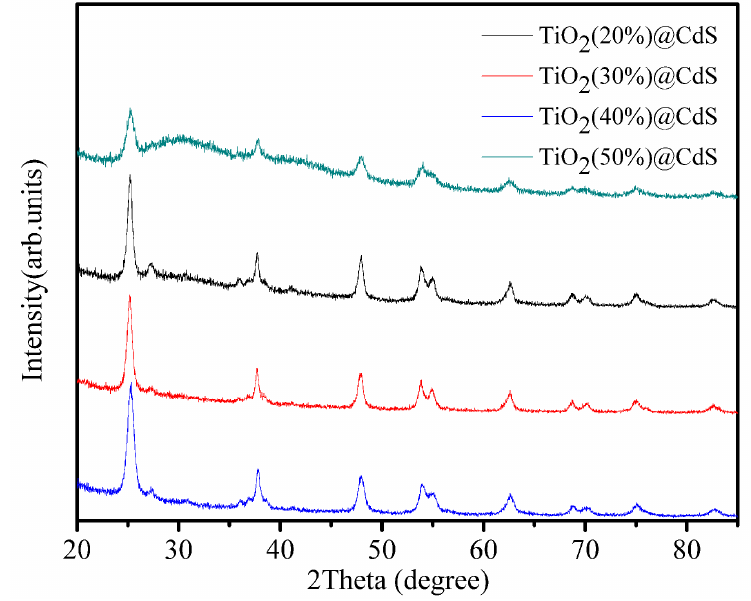
Figure 3. XRD pattern of TiO 2 nanorod–CdS nanoparticles.